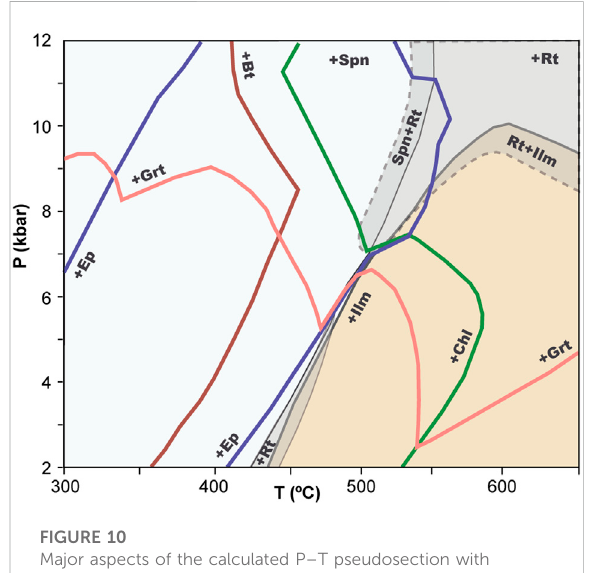
FIGURE 10 Major aspects of the calculated P – T pseudosection with PERPLE_X for the sample FO1710. The mineral abbreviation used was extracted from the work of Whitney and Evans